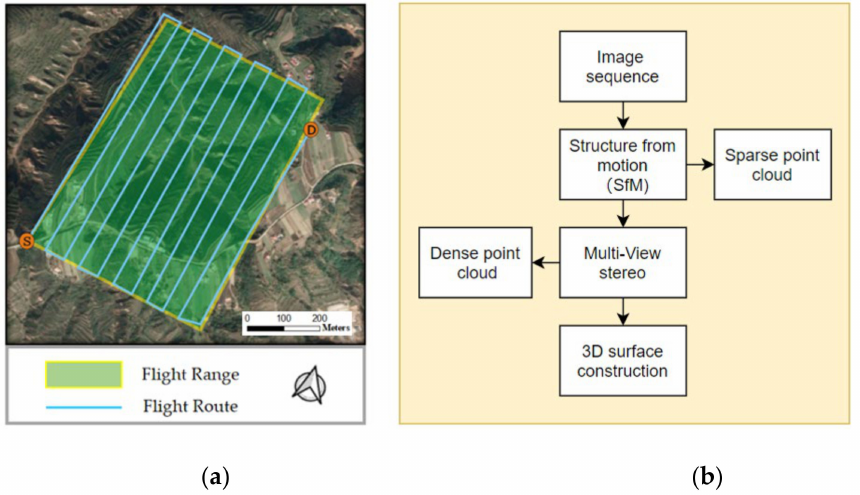
Figure 10. UAV data processing technology based on SfM-MVS: ( a ) route flight module; ( b ) SfM- MVS workflow.